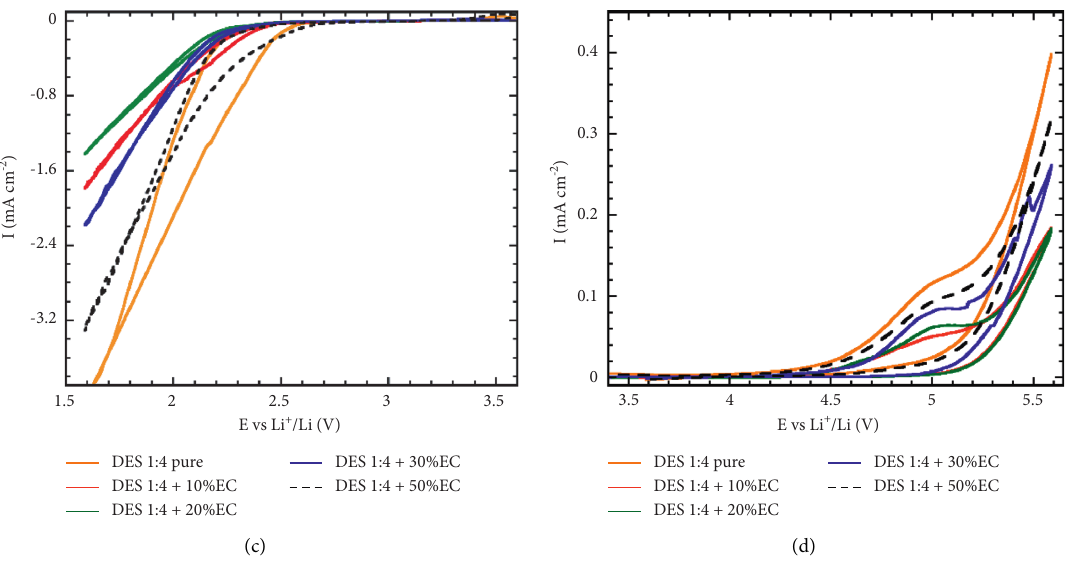
Figure 3: CV curves representing the oxidation (b, d) and reduction (a, c) limit of DES-based Table 3: Oxidation and reduction limit potentials of mixture DES 1: 4 + x %wt. AN and DES 1: 4 + y % wt. EC. x (%) E anode (V) E cathode (V) y 0% wt. AN